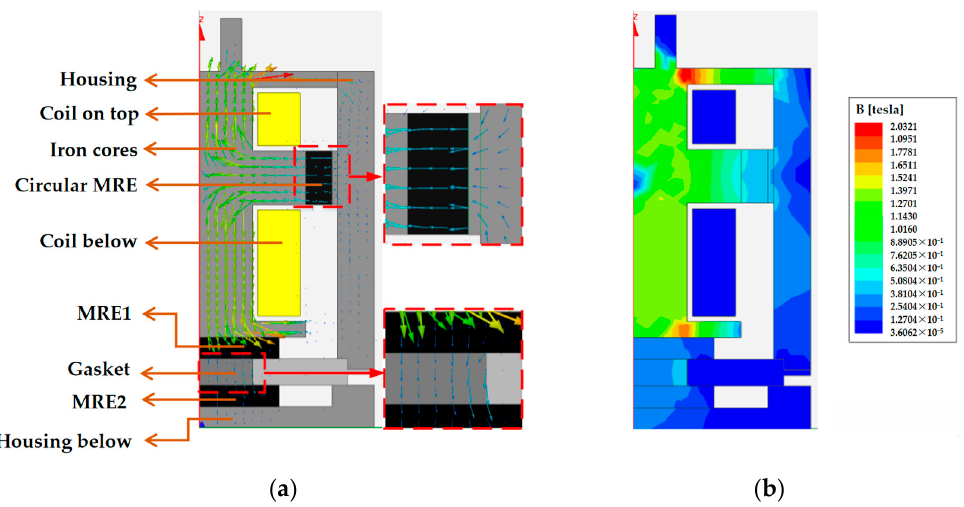
Figure 7. Simulation of the magnetic field of a vibration isolator under a 2-A applied current: ( a ) vector image and ( b ) magnitude image.